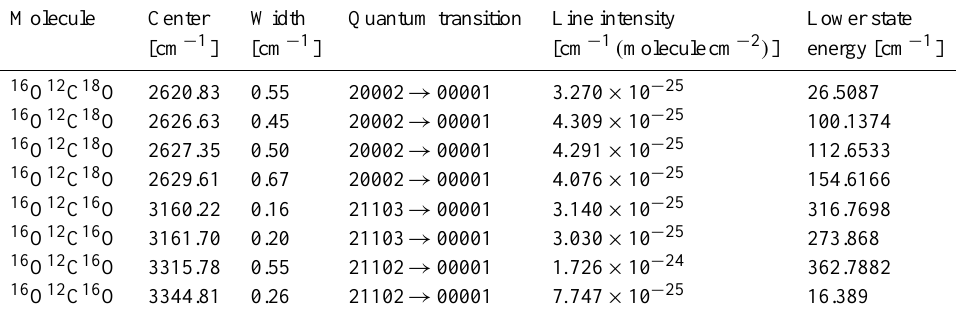
Table 1. The mid-IR microwindows used in this study. Each window is characterized by the center wavenumber and its width. Additionally, the corresponding molecular transition is given. Data taken from Rothman et al. (2005, 2009). Example spectral microwindows are shown in Fig. 1. Molecule Center Width